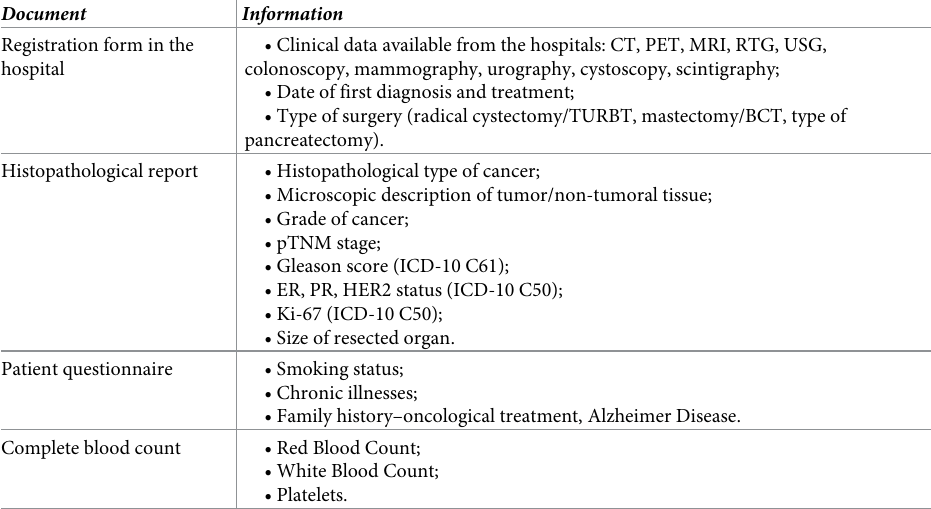
Table 3. Type of data collected from medical records of